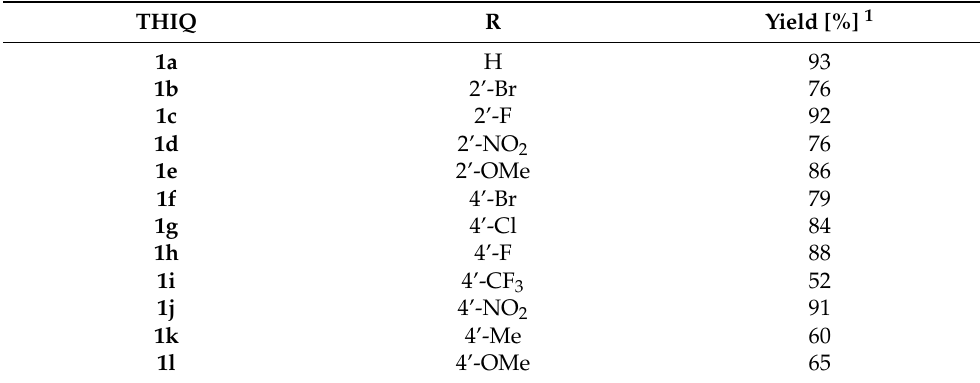
Table 3. Yields of phosphate salt-mediated Pictet-Spengler reaction.